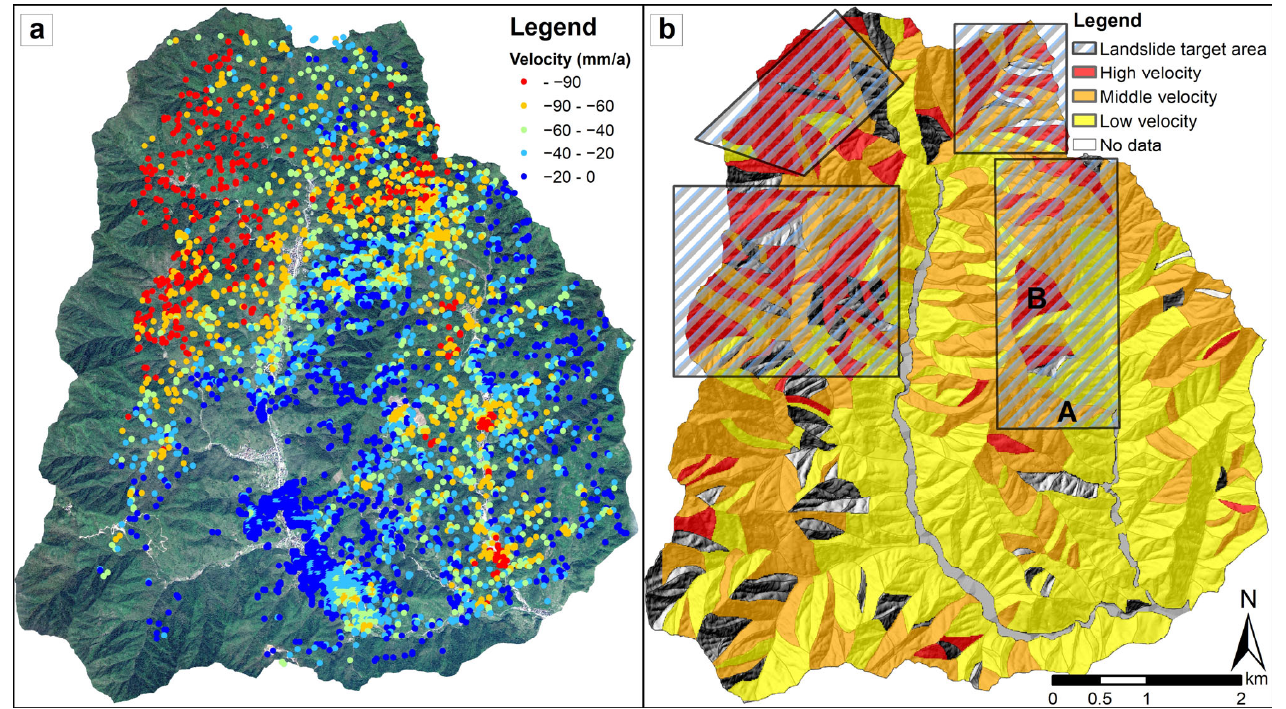
Figure 5. Deformation map of the Miaoyuan catchment. ( a ) Deformation map interpreted by InSAR, and displacement information is missing on the slope, ( b ) Deformation map of slope unit.